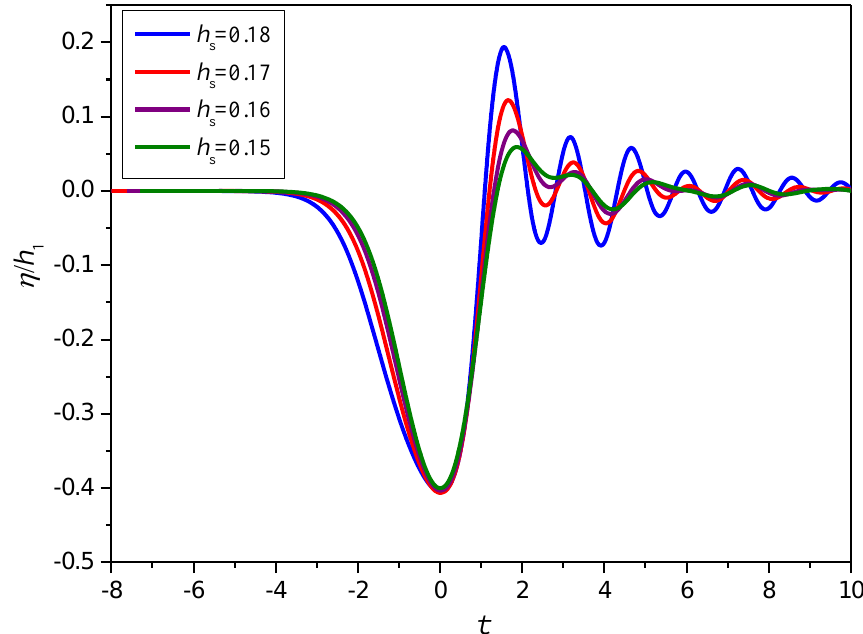
Figure 14. Characteristics of the tail waves under different slope height conditions.